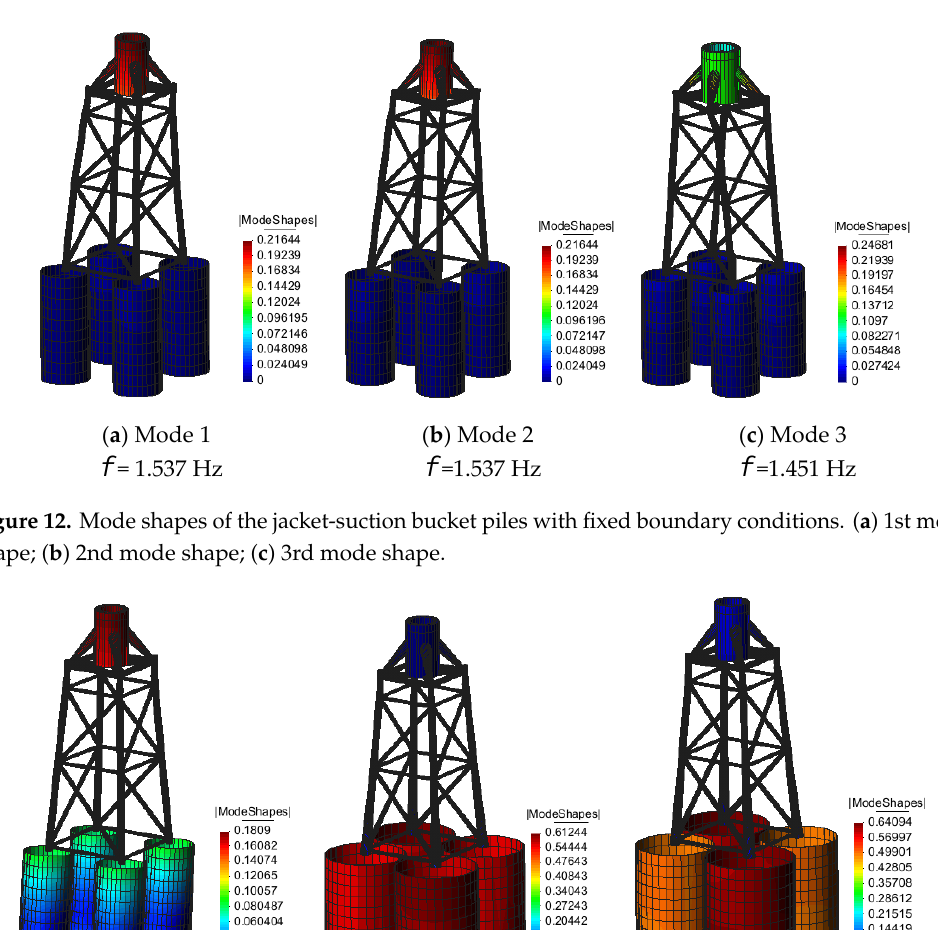
Figure 12. Mode shapes of the jacket-suction bucket piles with fixed boundary conditions. ( a ) 1 st mode shape; ( b ) 2 nd mode shape; ( c ) 3 rd mode shape.